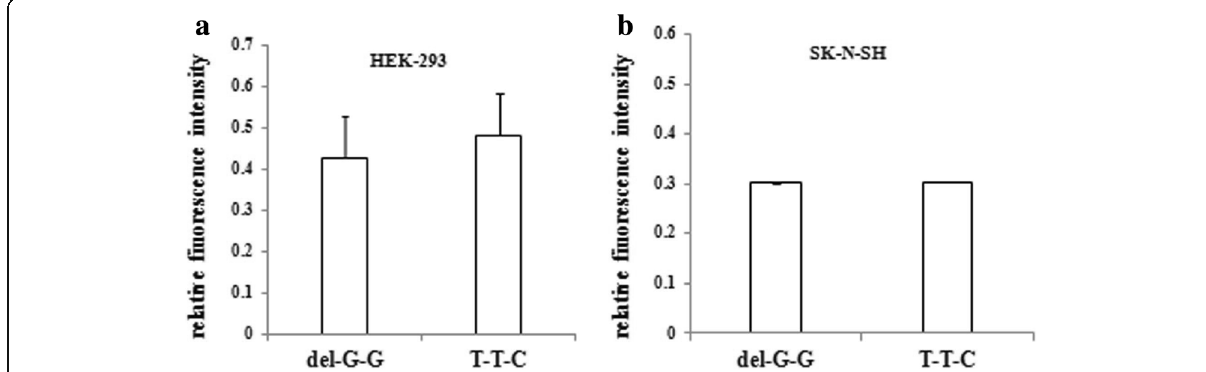
Fig. 4 Relative fluorescence intensity of two different recombinant haplotypes in HEK-293 and SK-N-SH cells. a and b represent the relative fluorescence intensity (LUC/TK values) of two haplotypes in HEK-293 cells and SK-N-SH cells, respectively. Del-G-G represents the haplotype T-del-G-G-C-G-G; T-T-C represents the haplotype T-insT-T-G-C-C. There was no significant difference in relative fluorescence intensities between the T-del-G-G-C-G-G and T-insT-T-G-C-G-C haplotypes in HEK-293 ( p =0.178) or SK-N-SH cells ( p